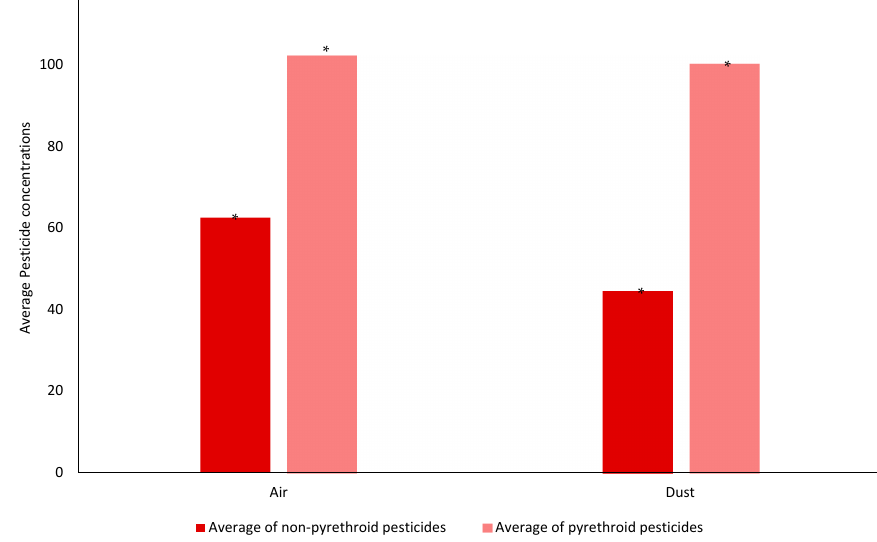
Figure 7. Average concentration of pyrethroid and nonpyrethroid pesticides in air (ng sampler − 1 ) and dust (ng g − 1 ) over one year in the nine residences assessed. Asterisks (*) denotes the means that are significantly different ( p < 0.05) between the pyrethroids and nonpyrethroid pesticides in each matrix.